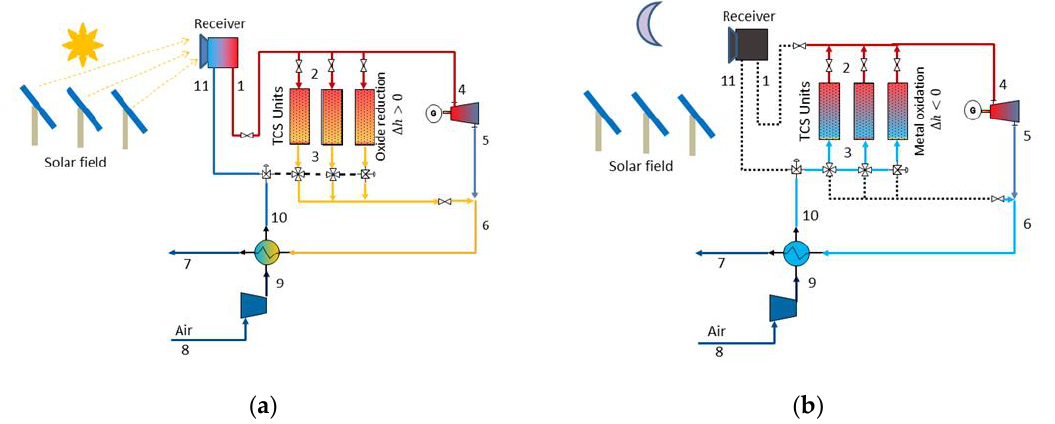
Figure 11. Integration scheme for a solar tower plant/TCS unit (oxide systems)/power block with expansion valves upstream of the reactor: ( a ) on-sun operation; ( b ) off-sun operation.